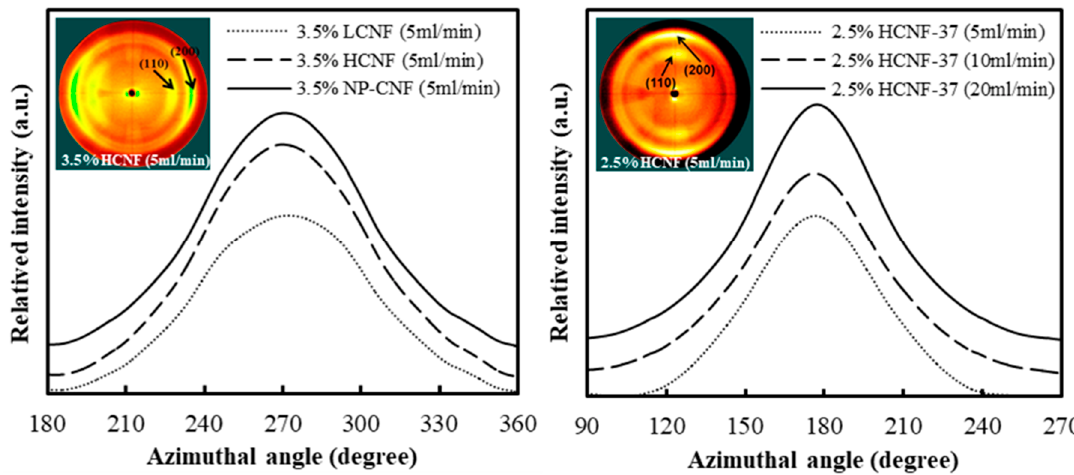
Figure 4. Azimuthal profiles of the (200) reflections from 2D X-ray diffractograms of the wet-spun filaments made from LCNF, HCNF, and NP-CNF, with different concentrations and spinning rates.